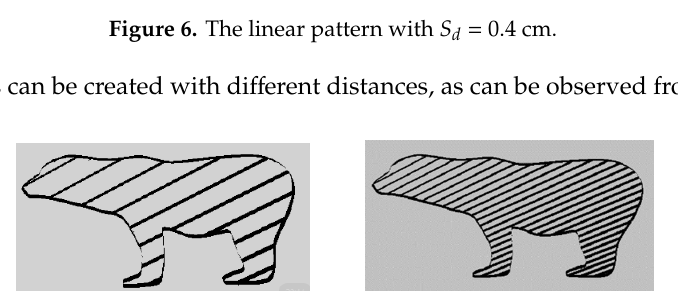
Figure 6. The linear pattern with S d = 0.4 cm.